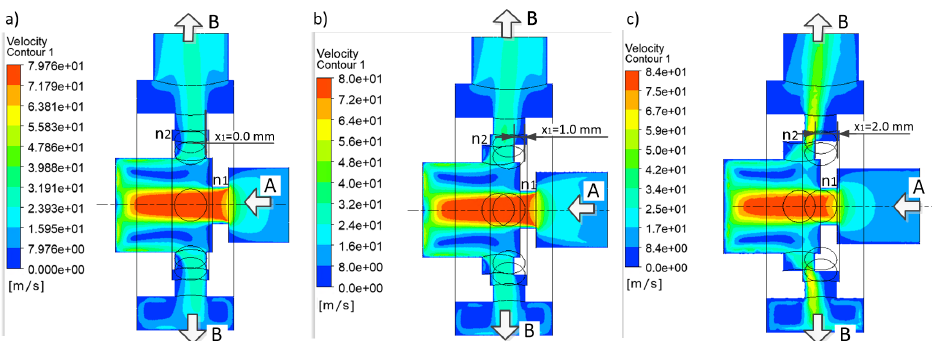
Figure 7. Velocity distribution depending on the spool position: ( a ) x 1 = 0.0 mm, ( b ) x 1 = 1.0 mm, ( c ) x 1 = 2.0 mm; A—inflow port; B—outflow port; n 1 , n 2